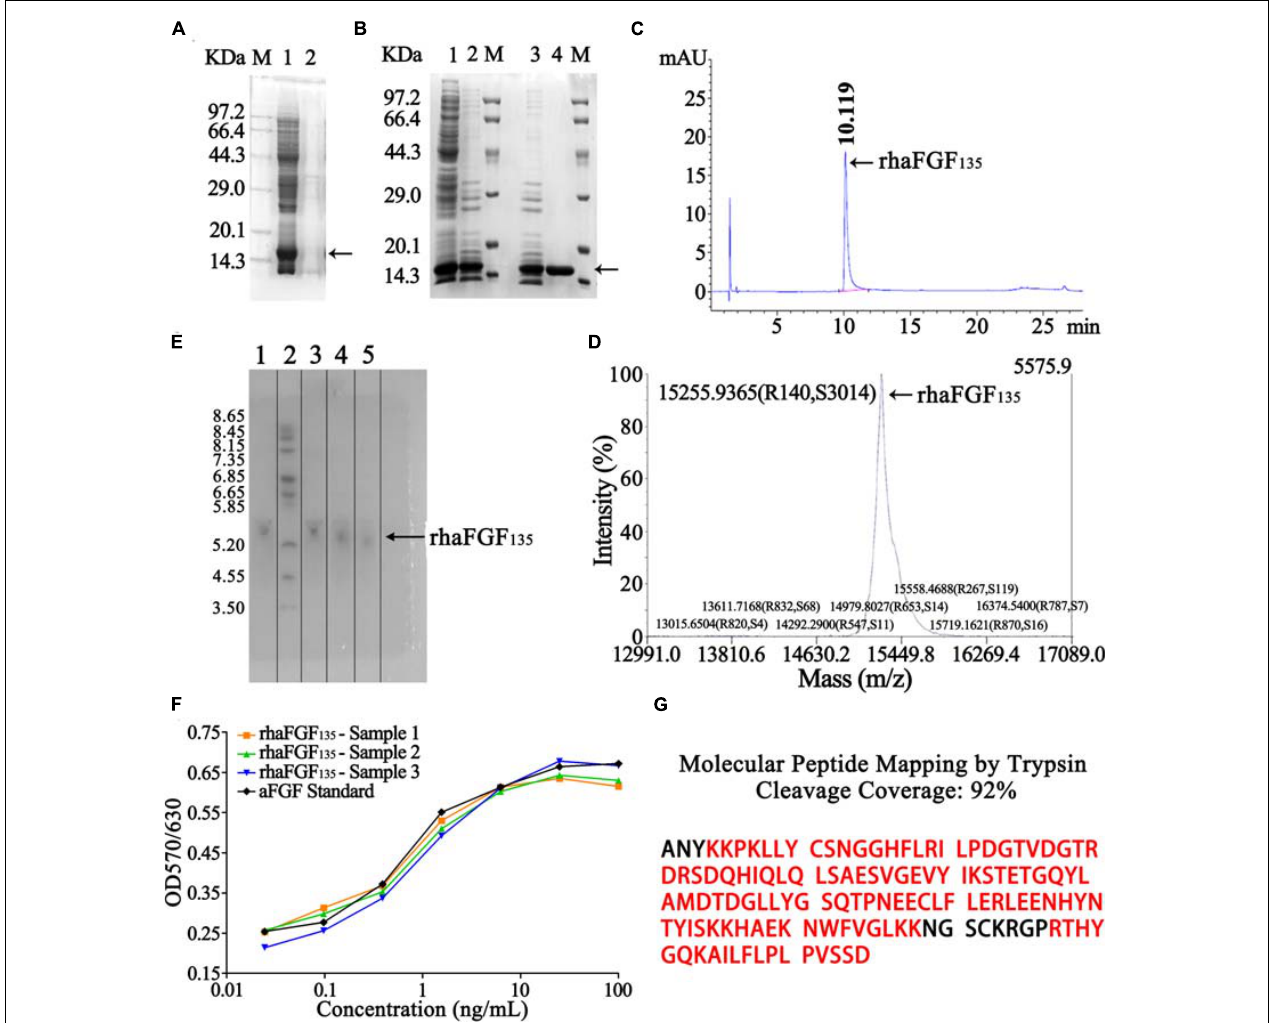
FIGURE 5 | Analysis and identification of rhaFGF 135 in the process of purification. (A) SDS-PAGE analysis of rhaFGF 135 in bacteria lysis stage. Lane M, molecular weight marker. Lane 1, supernatant containing rhaFGF 135 . Lane 2, precipitate. (B) SDS-PAGE analysis of rhaFGF 135 in ion exchange and affinity chromatography. Lane 1, supernatant. Lane 2 and 3, eluted sample with 0.6 M NaCl solution by CM-Sepharose. Lane 4, purified rhaFGF 135 eluted with 1.3 M NaCl by heparin affinity-Sepharose. Lane M, molecular weight marker. (C) RP-HPLC analysis of purified rhaFGF 135 . (D) Mass spectrum analysis of purified rhaFGF 135 . (E) Isoelectric point analysis of purified rhaFGF 135 . Lane 1, rhaFGF standards. Lane 2, isoelectric point marker. Lanes 3–5, purified rhaFGF 135 from three batches. (F) The biological activity of rhaFGF 135 on NIH-3T3 cells. (G) Molecular peptide mapping coverage of rhaFGF 135 . The matched amino acids were marked in red. Black arrows indicate rhaFGF 135 protein.